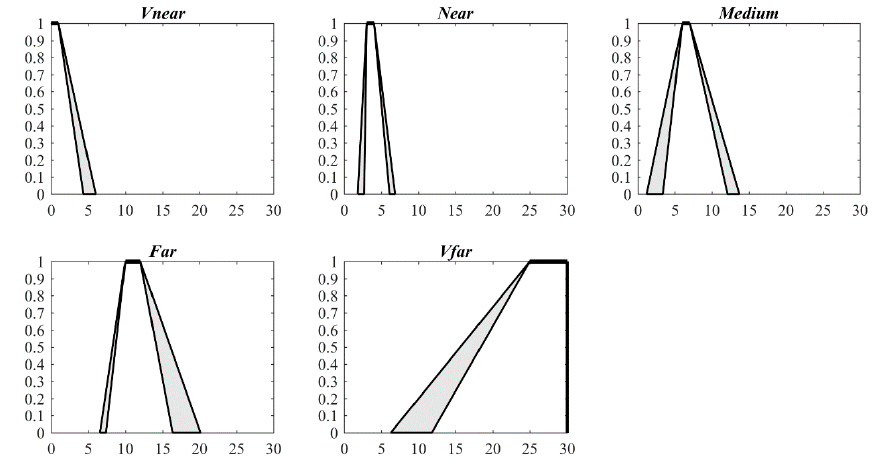
Figure 6. IT2 FSs of five qualitative distance words for public transportation (unit: km). ISPRS Int. J. Geo-Inf. 2018 , 7 , x FOR PEER REVIEW